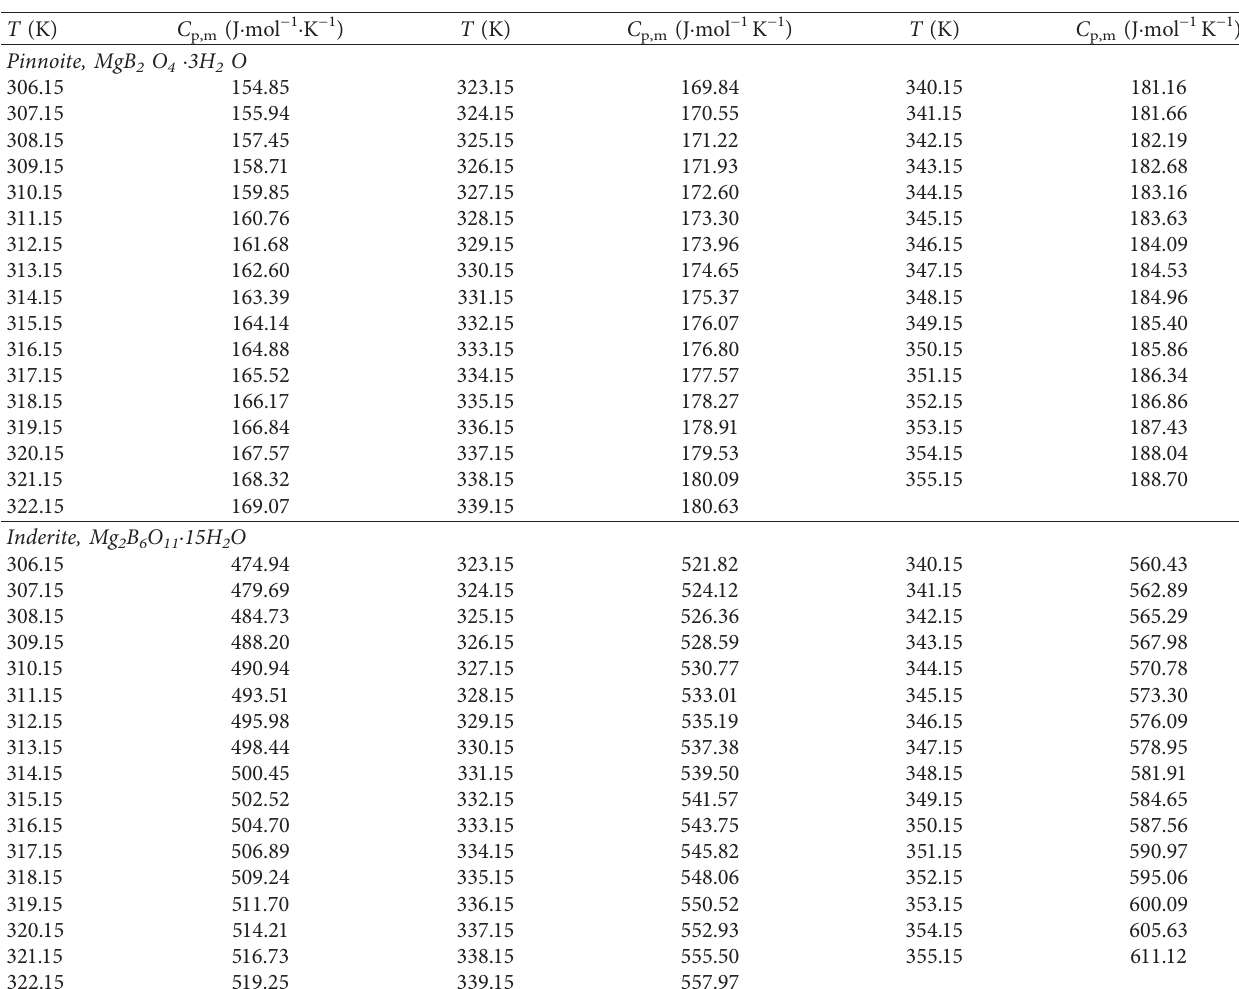
Table 2: The molar heat capacities of pinnoite and inderite at 306.15 ∼ 355.15K a